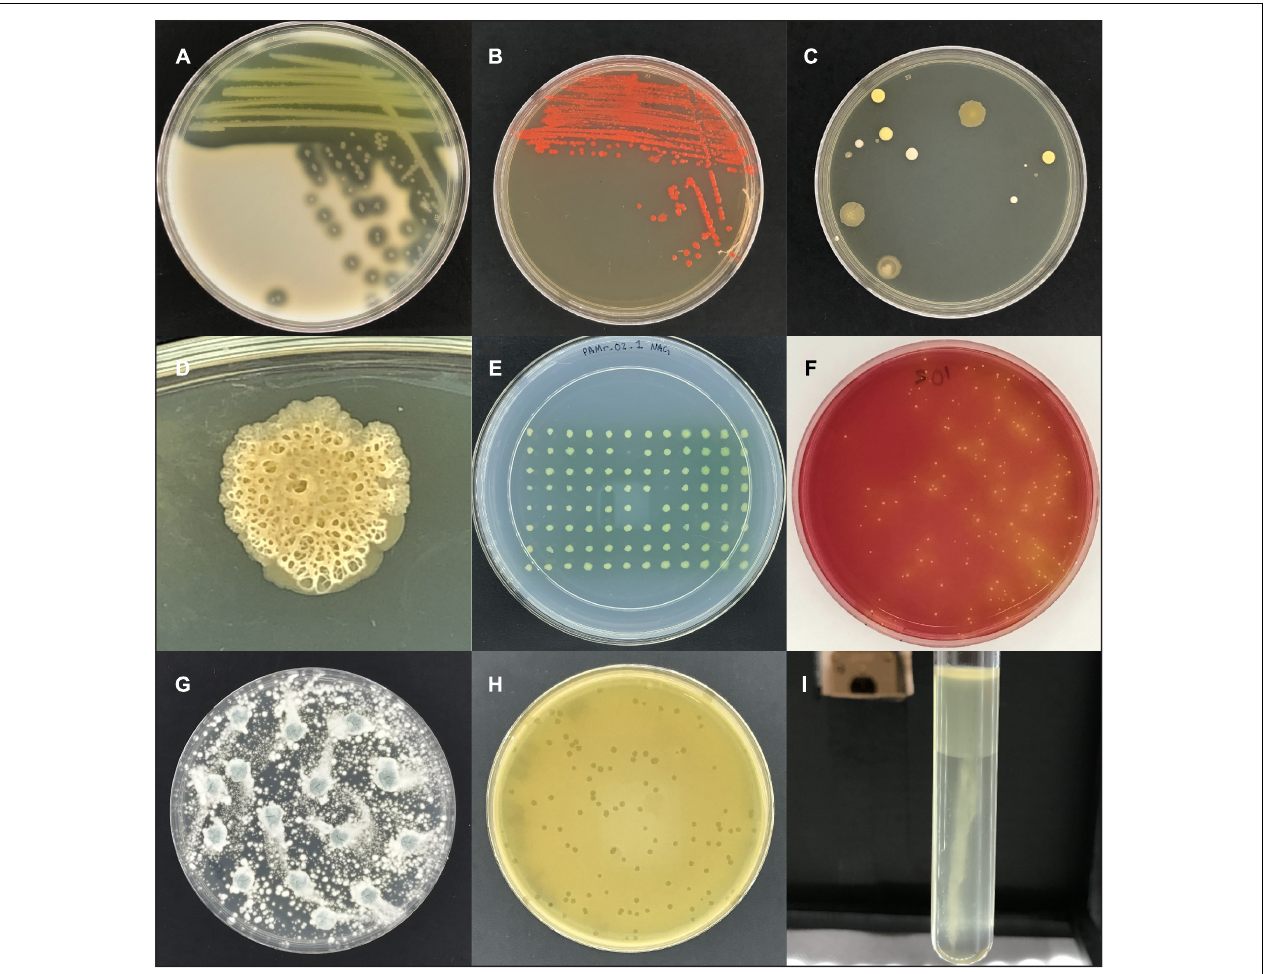
FIGURE 4 | Images captured with the imaging box. (A) Area of clearing on skim milk plates caused by protease secretion of P. aeruginosa . (B) Colonies of E. coli labeled with the red fluorescent protein DsRed-Express2. (C) Colonies of unknown microbes on an agar plate that was left open to the environment. (D) Close-up image of an unknown microbial colony. (E) Replica plate from the P. aeruginosa transposon mutant screening experiment. The three positions without a colony (B6, D8, and E7) represent non-growing mutant candidates. (F) A potato salad sample plated on mannitol salt plates to detect mannitol fermenting S. aureus , indicative as yellow colonies with yellow zones. (G) A plate of Penicillium sp. (H) Bacteriophage c2 plaques in a lawn of Lactococcus lactis . (I) Growth of Proteus vulgaris , a facultative anaerobe, in oxygen-reducing sodium thioglycolate medium, with dense growth in the high oxygen region and sparse growth in the low oxygen